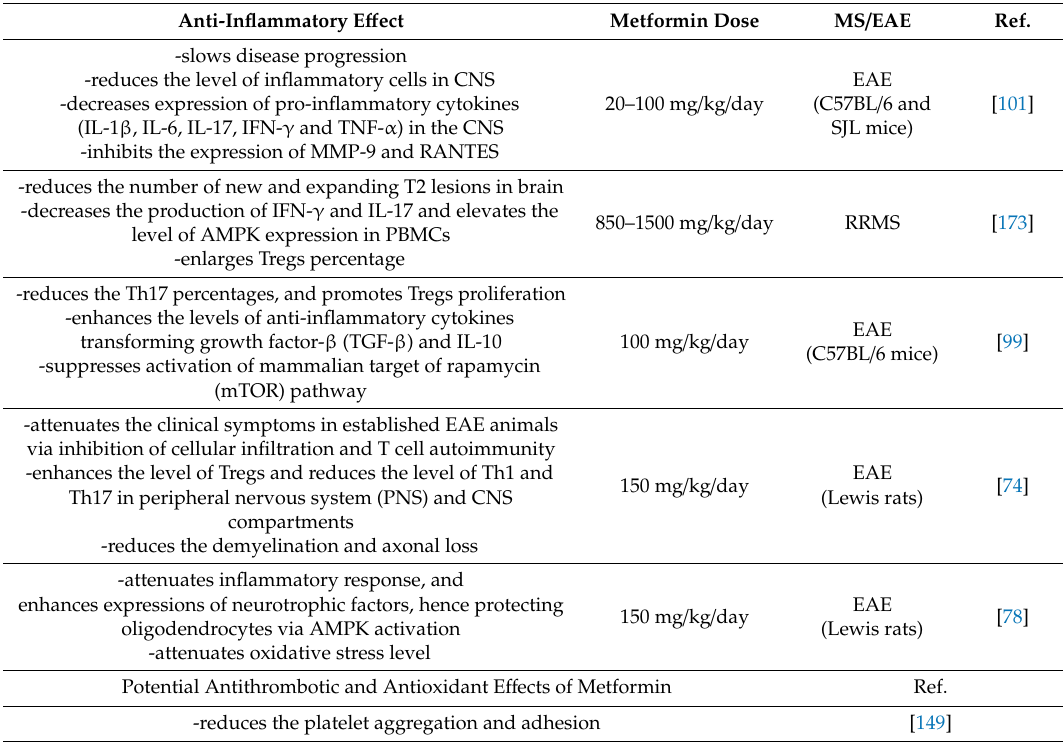
Table 1. Documented anti-inflammatory e ff ects of metformin application in MS / experimental encephalomyelitis (EAE) and potential antithrombotic / antioxidant e ff ects. Anti-Inflammatory E ff ect Metformin Dose MS / EAE